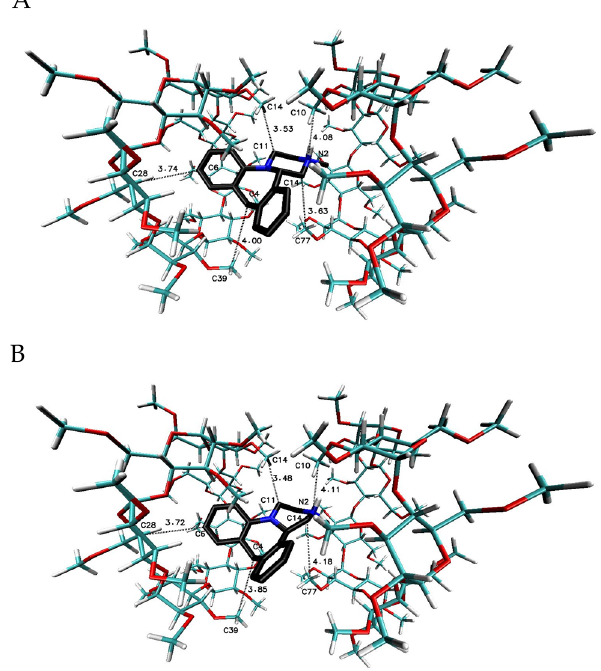
Figure 8. The chosen geometries of the MIA–TM β -CD complex with stoichiometry 1:2 (I-II or “head-to-head”) obtained by MD simulations with the use of TM β -CD crystal structure with refcode ALIGAE from the CSD data base [39]; ( A ) for S-(+)-MIA ∙ HCl and ( B ) for R-( − )-MIA ∙ HCl.